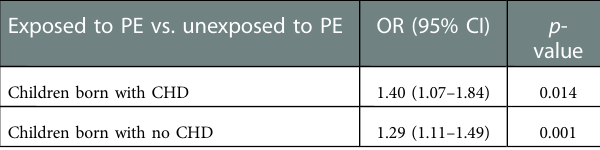
TABLE 5 Odds ratio (OR) of receiving special education if exposed to PE vs. unexposed to PE. Exposed to PE vs. unexposed to